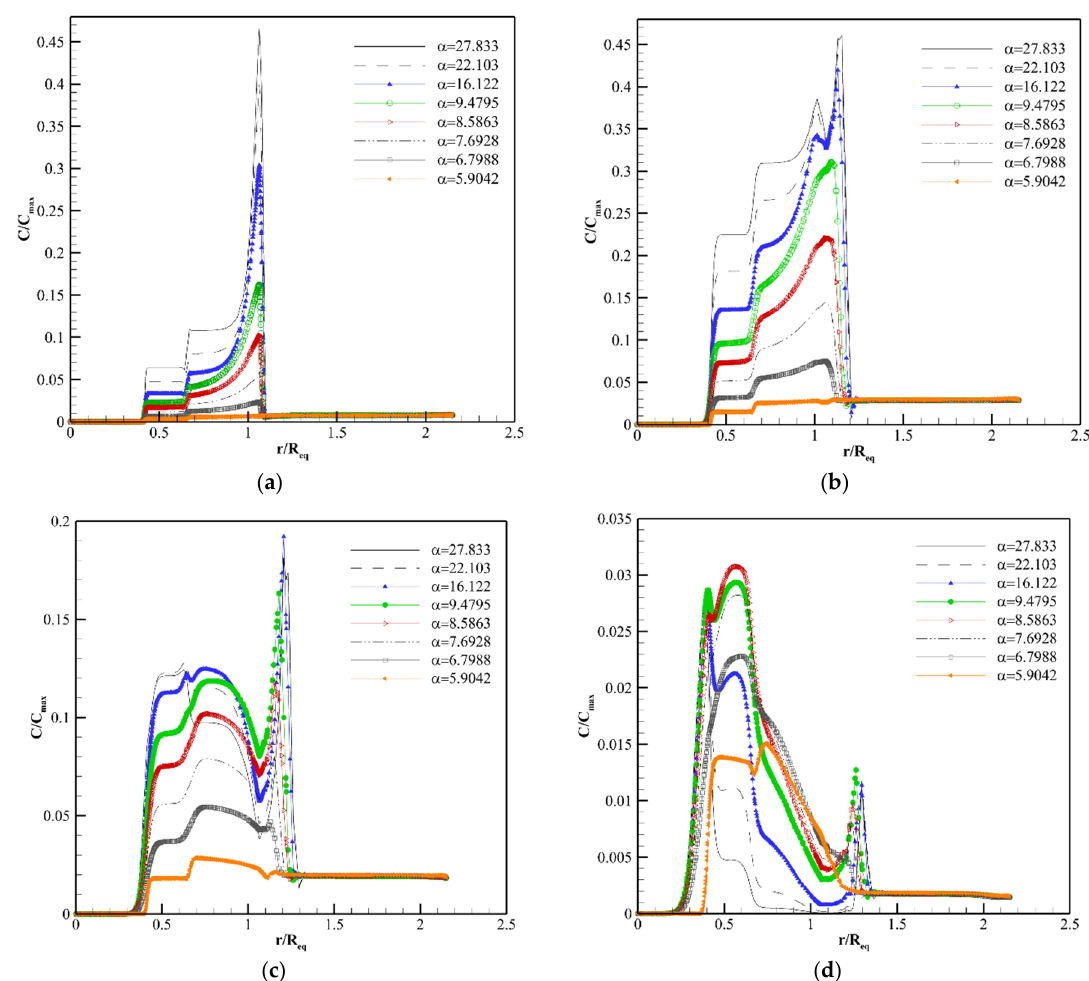
Figure 10. Distribution of F ( ab (cid:48) ) concentration along line 1. ( a ) 1 h post-injection. ( b ) 8 h post-injection. ( c ) 24 h post-injection. ( d ) 72 h post-injection.